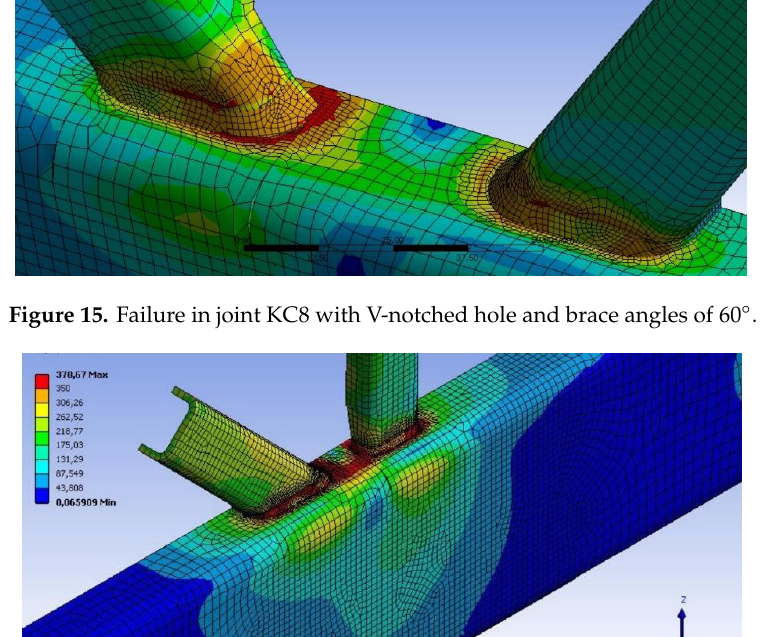
Figure 14. Failure in joint KB4 with semi-circular hole and brace angles of 55°.